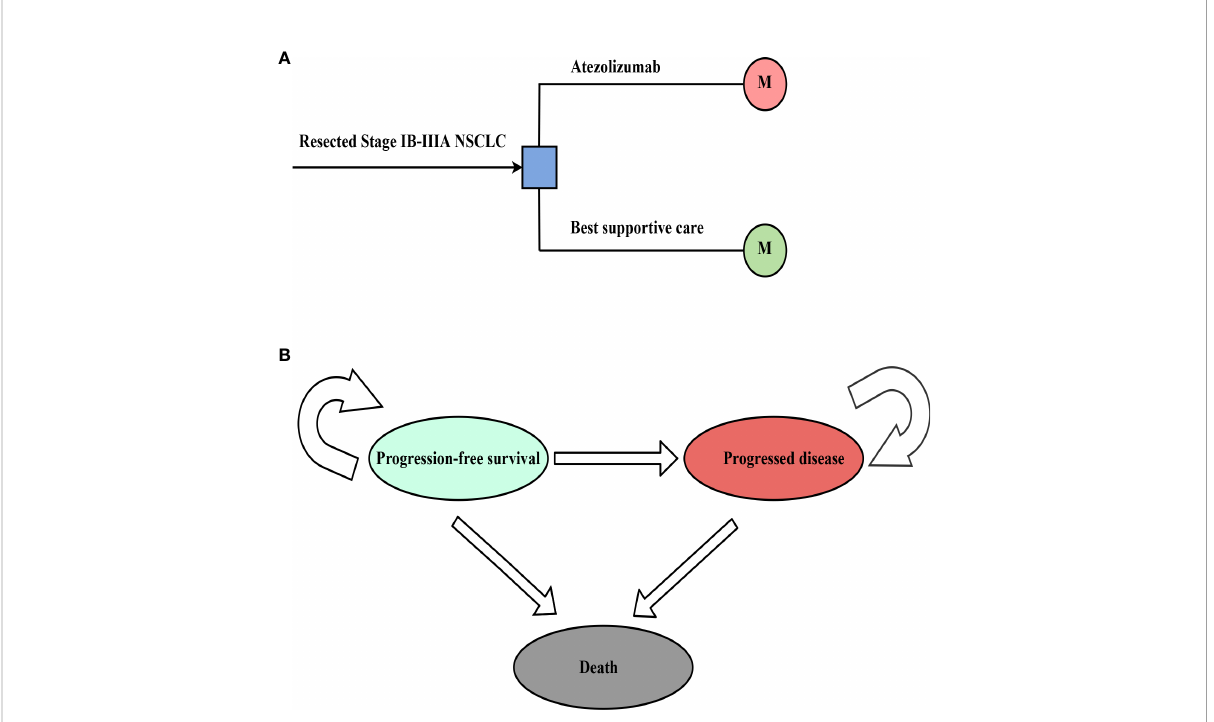
FIGURE 1 The structure of the (A) decision tree and (B) Markov model. NSCLC, non-small-cell lung